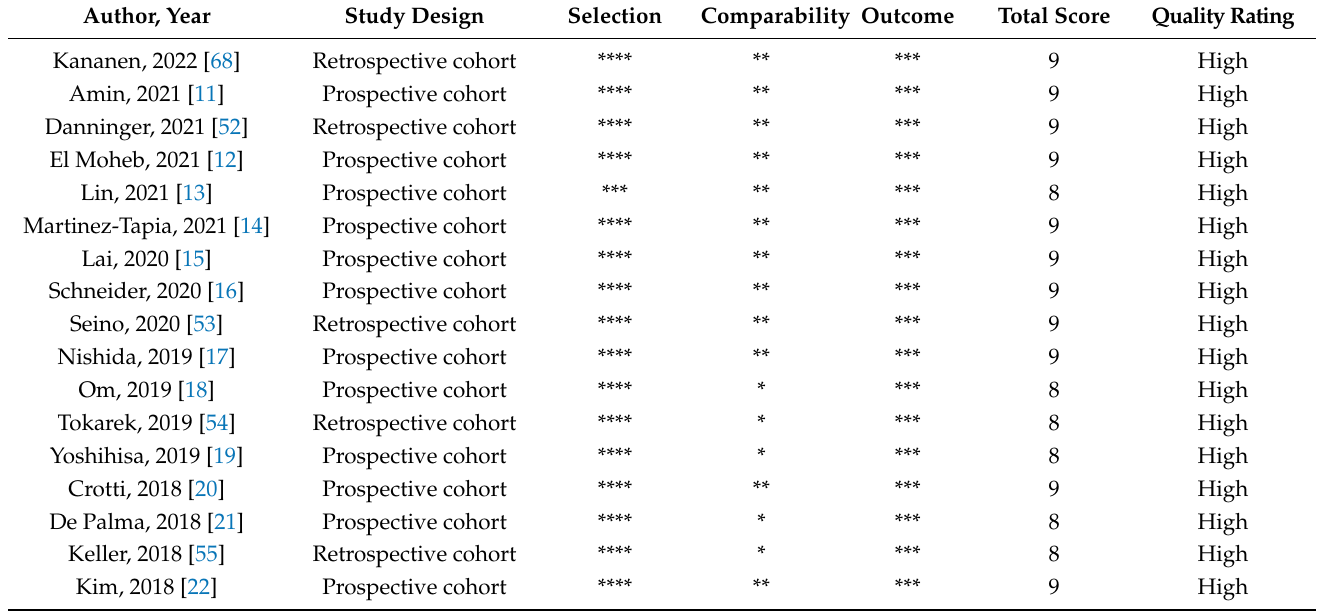
Table 3. Quality assessment of the different studies included in this systematic review, using the Newcastle–Ottawa scale